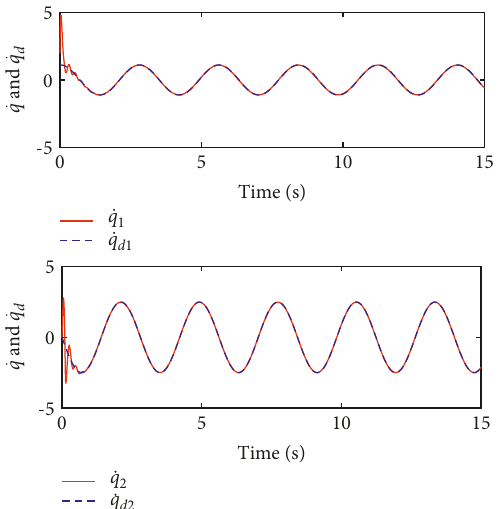
Figure 14: Tracking performance for _ q